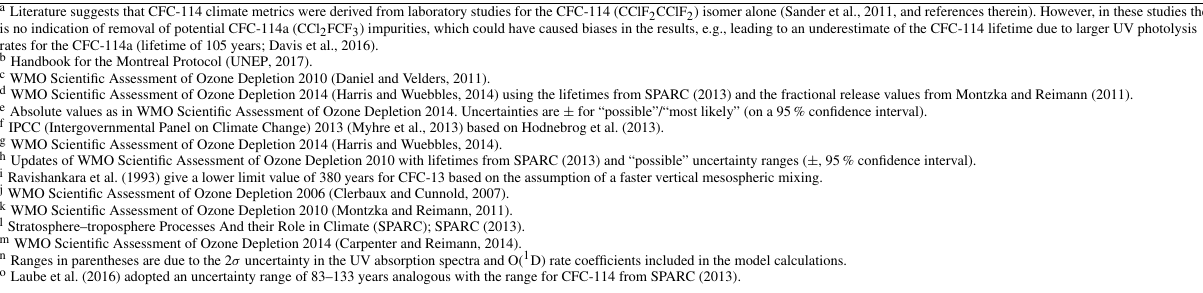
Table 1. Evolution of atmospheric metrics of CFC-13 (CClF 3 ), CFC-114 (CClF 2 CClF 2 ), CFC-114a (CCl 2 FCF 3 ), and CFC-115 (C 2 ClF 5 ). Ozone depletion potential (ODP) in Montreal Protocol